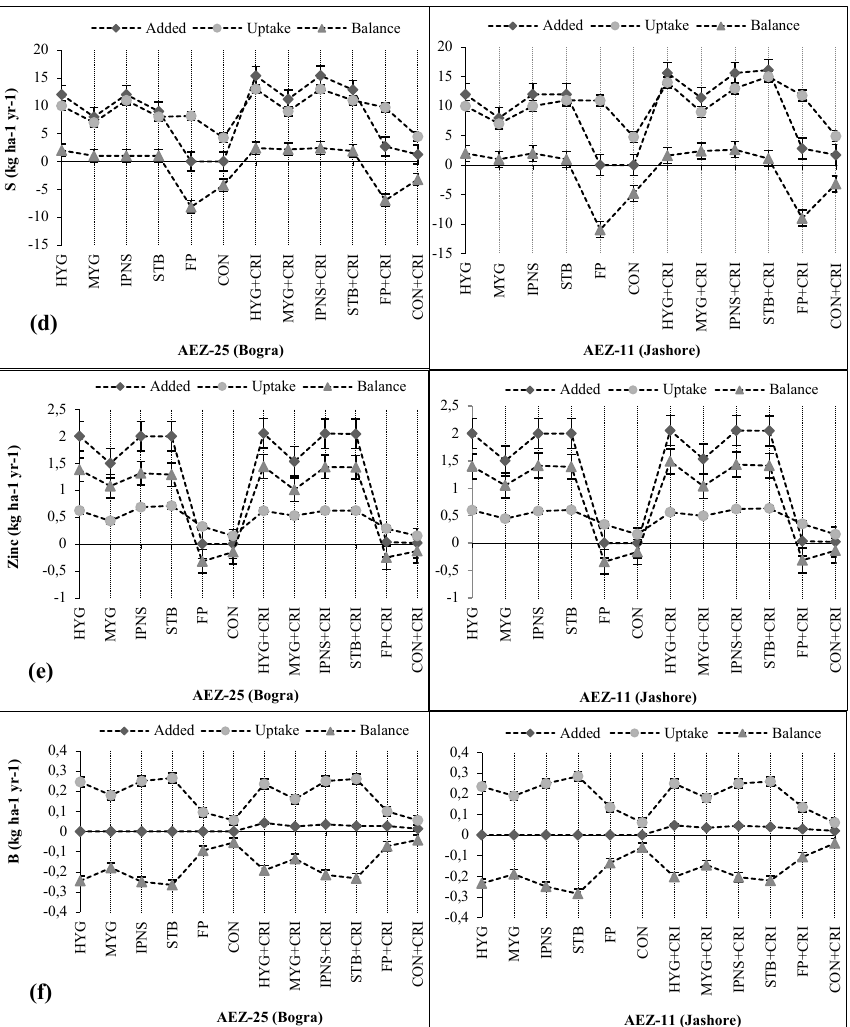
Figure 3: Sulphur ( d ) zinc (e) and ( f ) boron added, uptake and balance in rainfed monsoon rice field in two locations (AEZ-25 & AEZ-11) in Bangladesh after two years of nutrient management. Mean (±SD) was calculated from three replicates for each treatment and significantly different at P ≤ 0.05 (LSD test). HYG’; High Yield Goal, ‘MYG’; Moderate Yield Goal, ‘IPNS’; Integrated Plant Nutrient System, ‘STB’; Soil Test Based, ‘FP’; Farmer’s Practice, ‘CON’; without fertilizers, ‘CRI’: crop residue incorporation; N, Nitrogen; P, phosphorus; K, potassium.